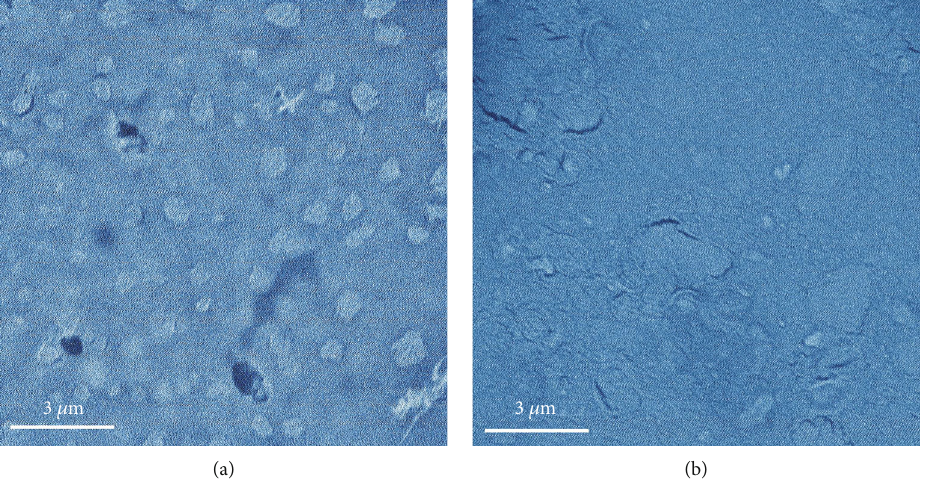
Figure 6: SEM images of (a) NF-k and (b) NF-c.